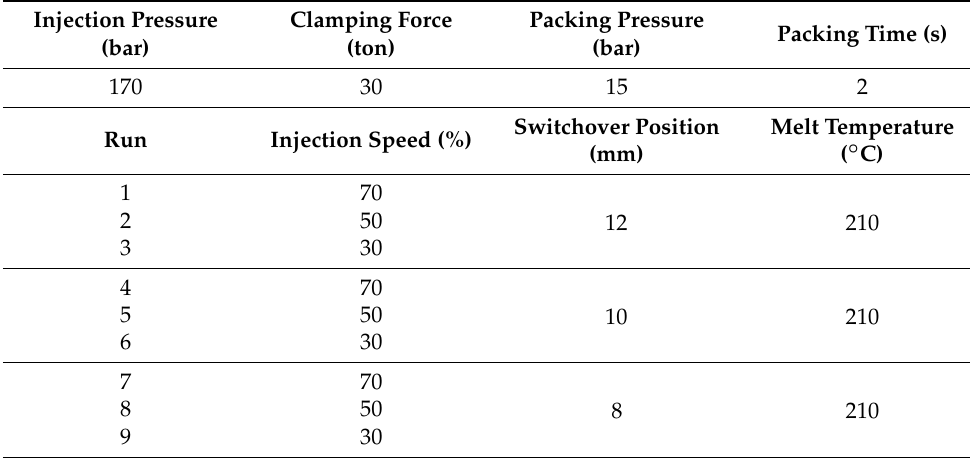
Table 1. Parameters of preliminary